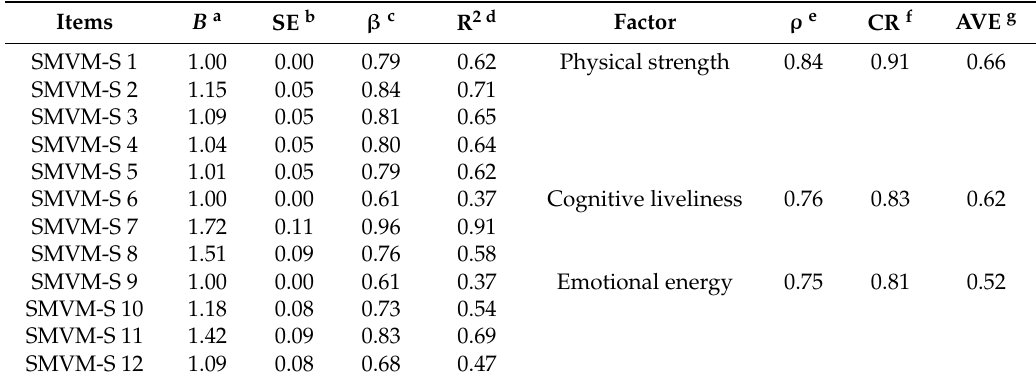
Table 2. Standardized and unstandardized coe ffi cients for CFA Model 4 and reliability indicators.